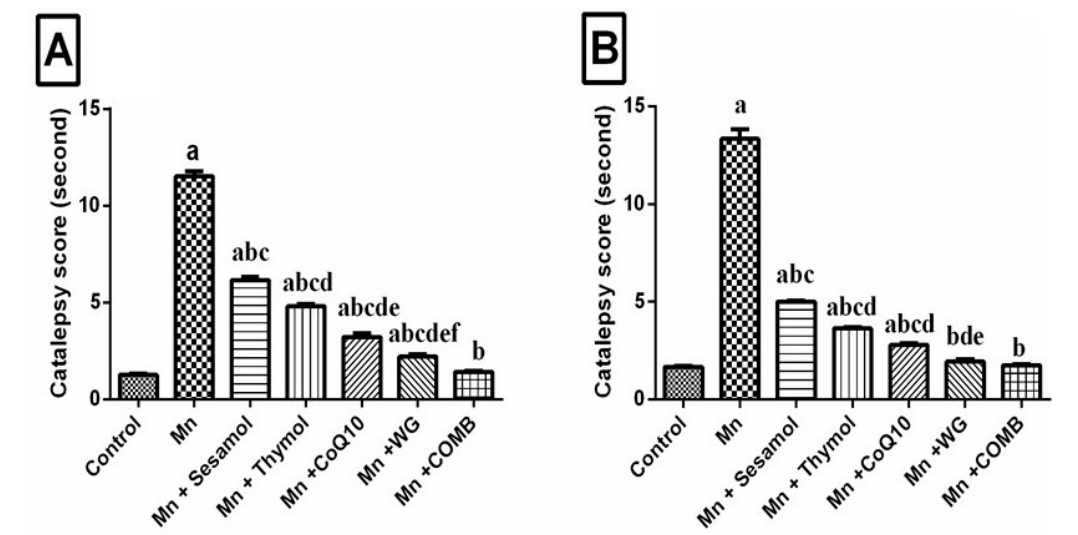
Figure 4. Effects of sesamol, thymol, CoQ10, wheat grass, or their combination on catalepsy score in ( A ) grid and ( B ) bar tests of rats treated with MnCl 2 . Values are means of 12 rats ± S.E.M, as compared with control (a), Mn (b), COMB (c), sesamol (d), thymol (e), and CoQ10 (f) groups. One-way ANOVA with posttest Tukey’s multiple comparison assessed the statistical differences between the various groups, p -value < 0.05. Table 1. Effect of sesamol, thymol, CoQ10, WG, or their combination on MnCl2-induced changes in brain monoamine levels and ACHE